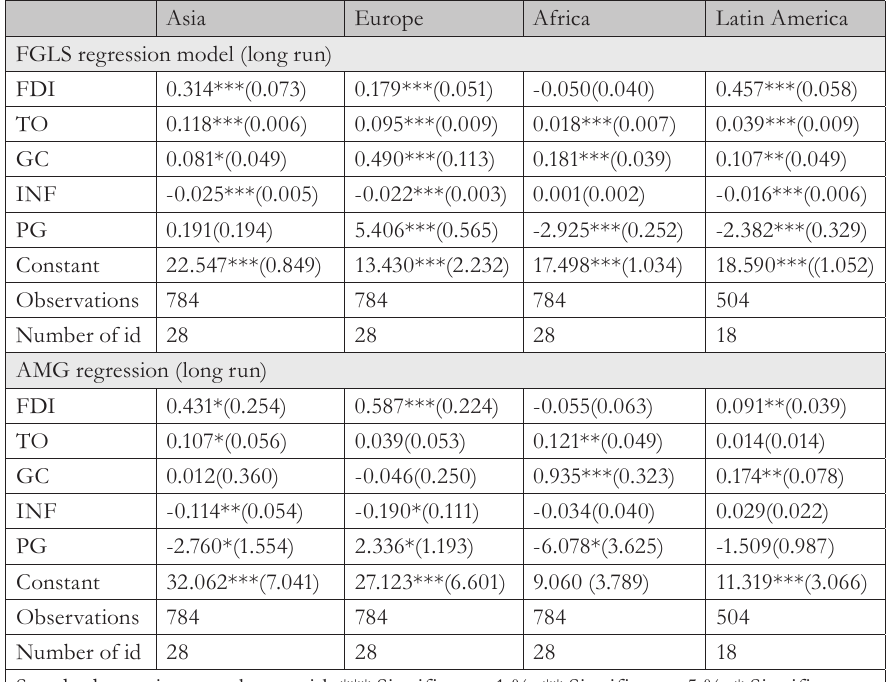
Tab. 4 – Regression results of FD in BRI countries. Source: own